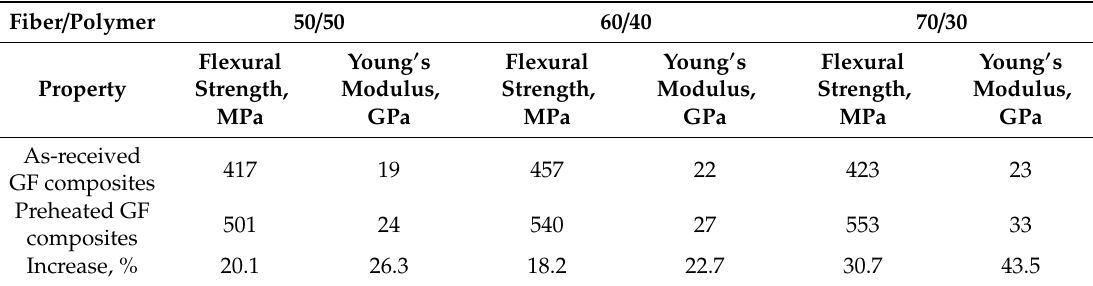
Table 1. The flexural strength and Young’s modulus for composites reinforced with as-received GF (route 3) and preheated at 350 ◦ C GF (route